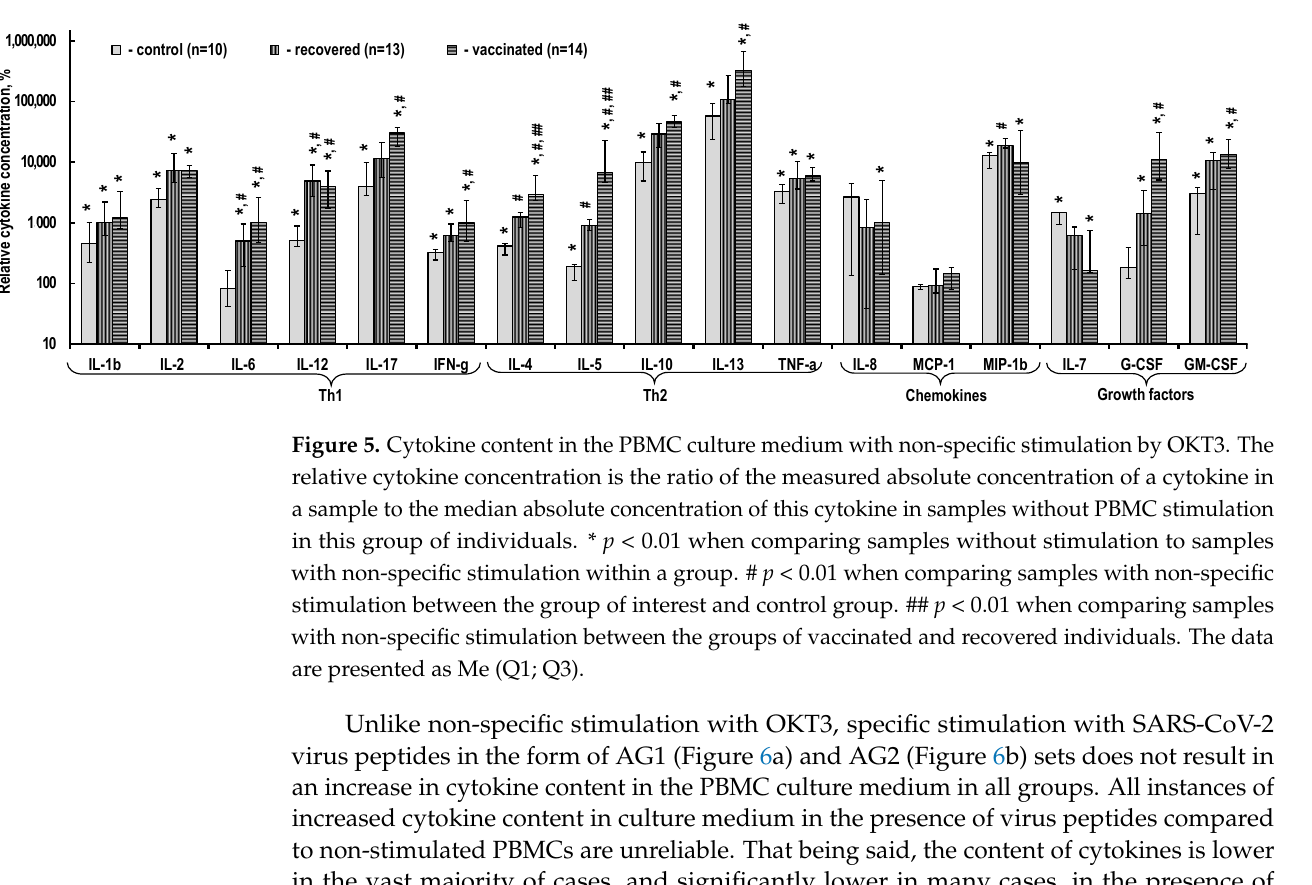
in cytokine content in recovered and vaccinated individuals.